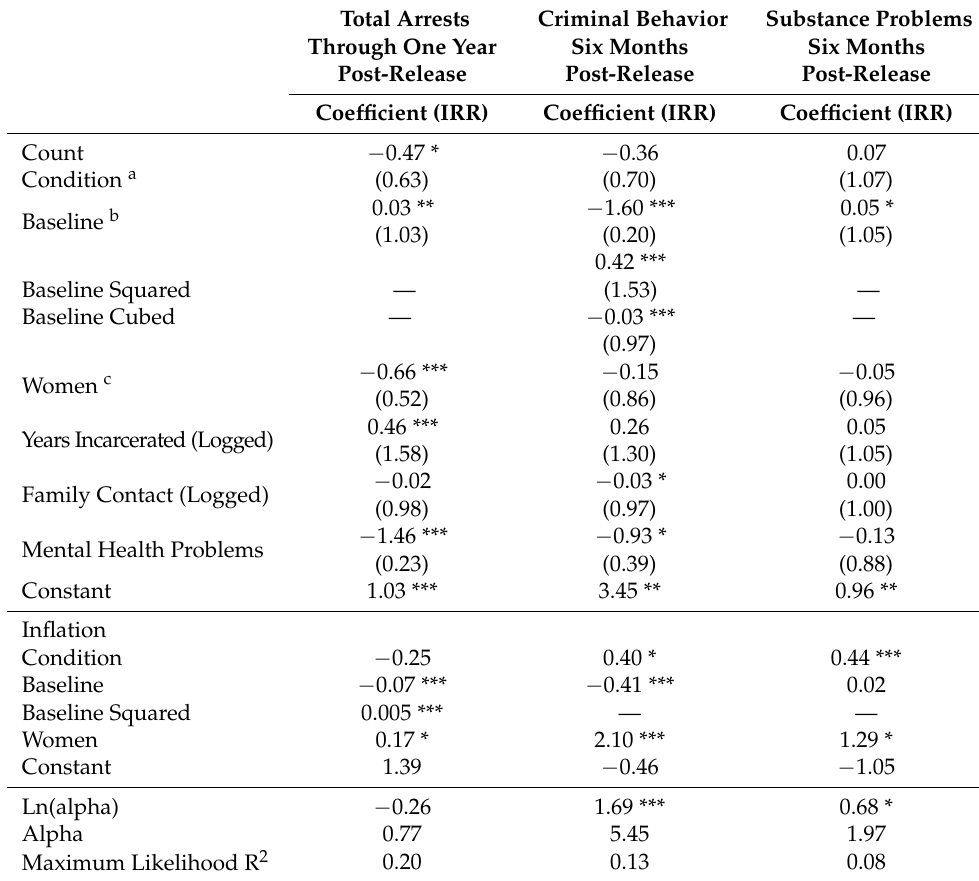
Table 2. Zero-inflated negative binomial regression